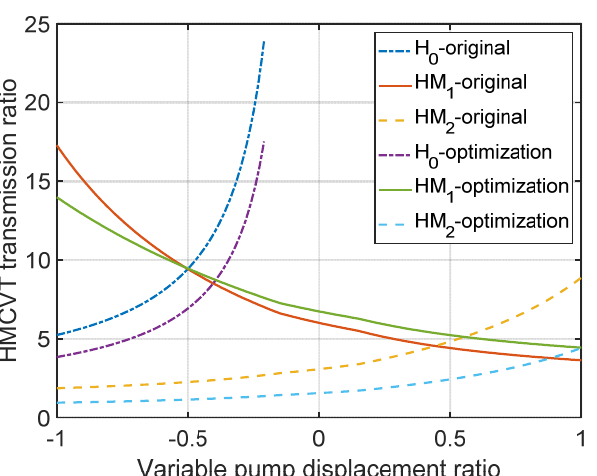
Figure 11. The comparison of speed regulating characteristics of transmission parameters before and after optimization.